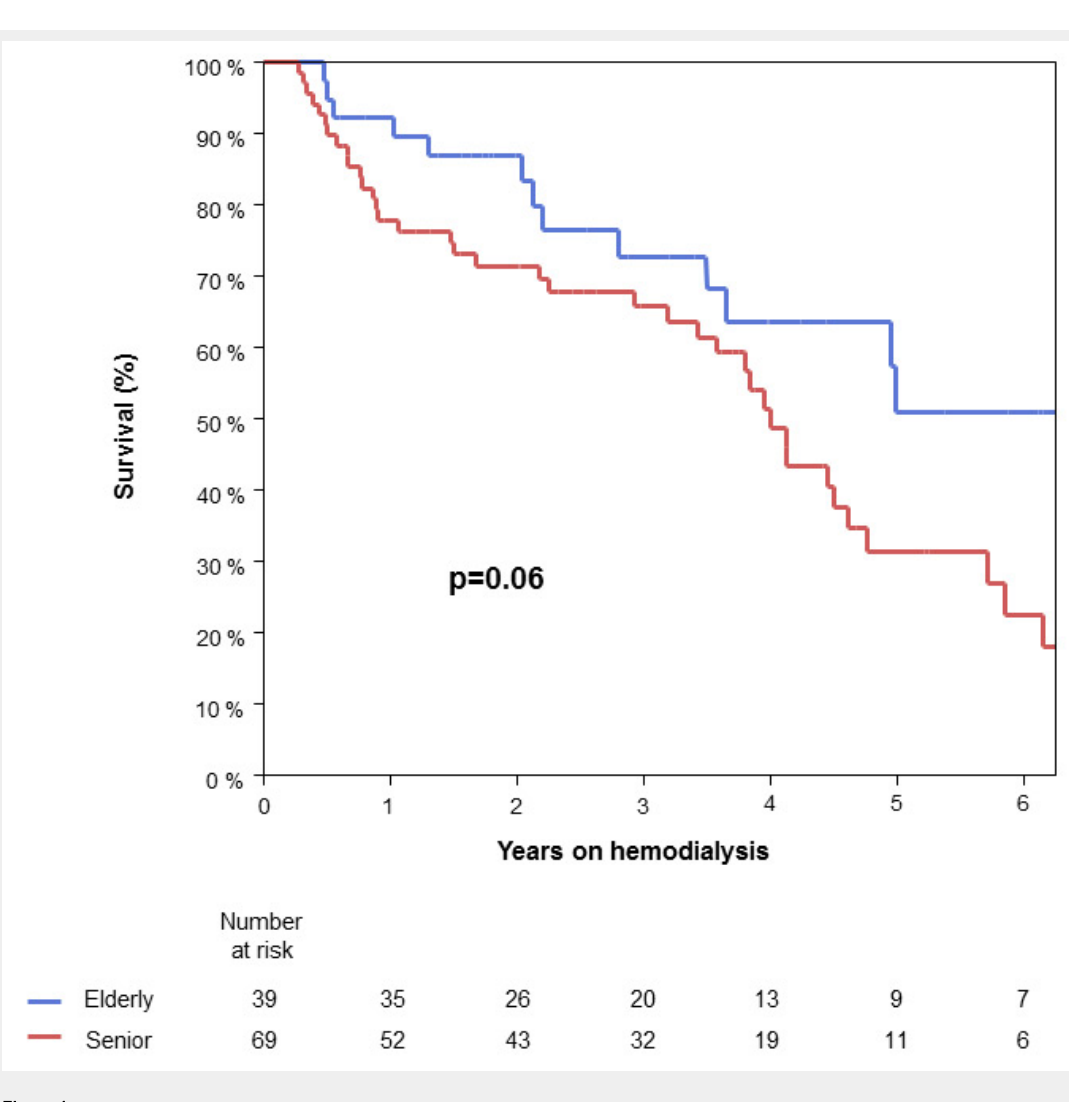
Figure 1 Patient survival The abscissa shows years after the start of haemodialysis and the ordinate shows patient survival as a